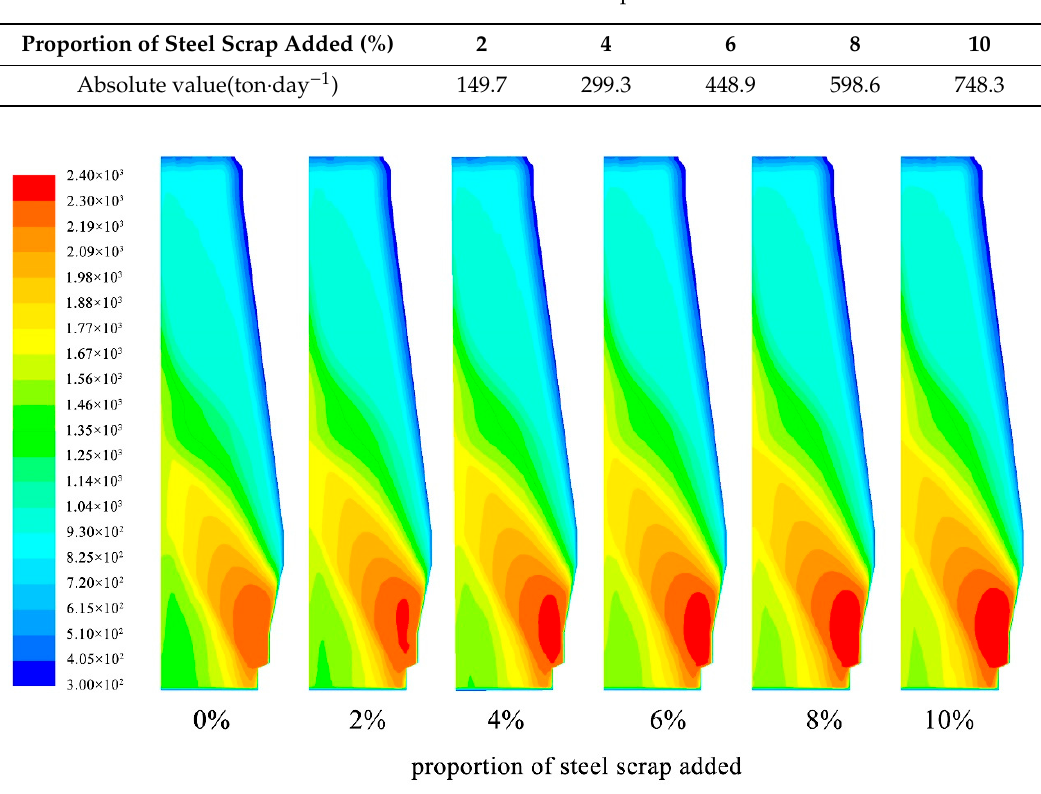
Table 6. Amount of steel scrap added.